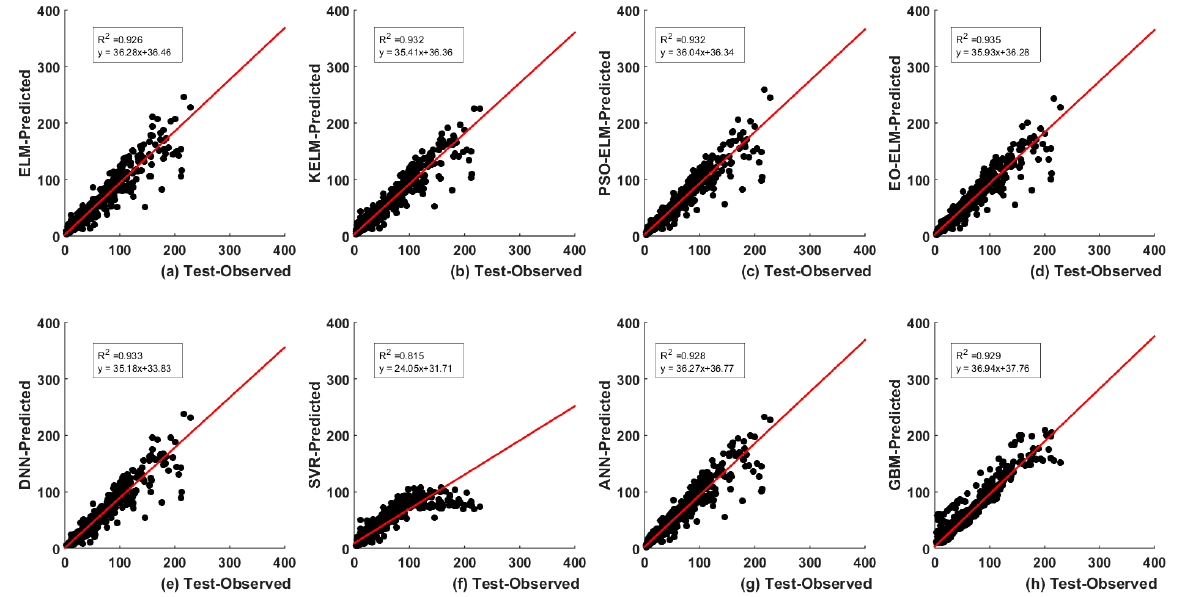
Figure 12. Prediction capability of the eight models in test case ( a ) ELM, ( b ) KELM, ( c ) PSO-ELM, ( d ) EO-ELM, ( e ) DNN, ( f ) SVR, ( g ) ANN, and ( h ) GBM for the catchment Teifi at Glanteifi.